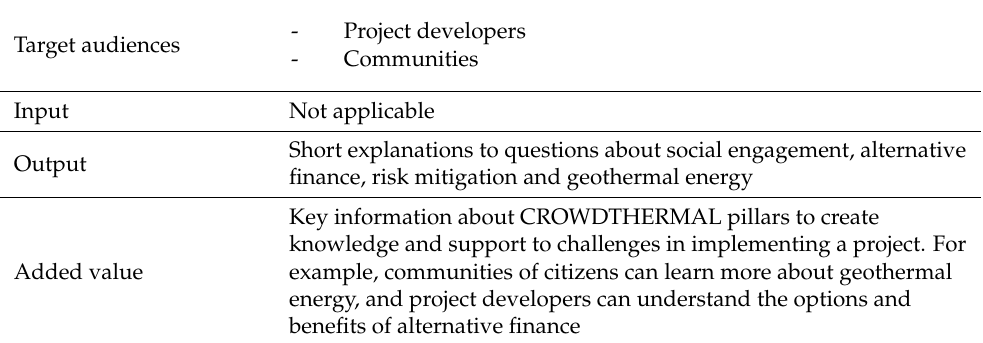
Figure 16. Frequently Asked Questions menu. Table 11. Frequently Asked Questions.